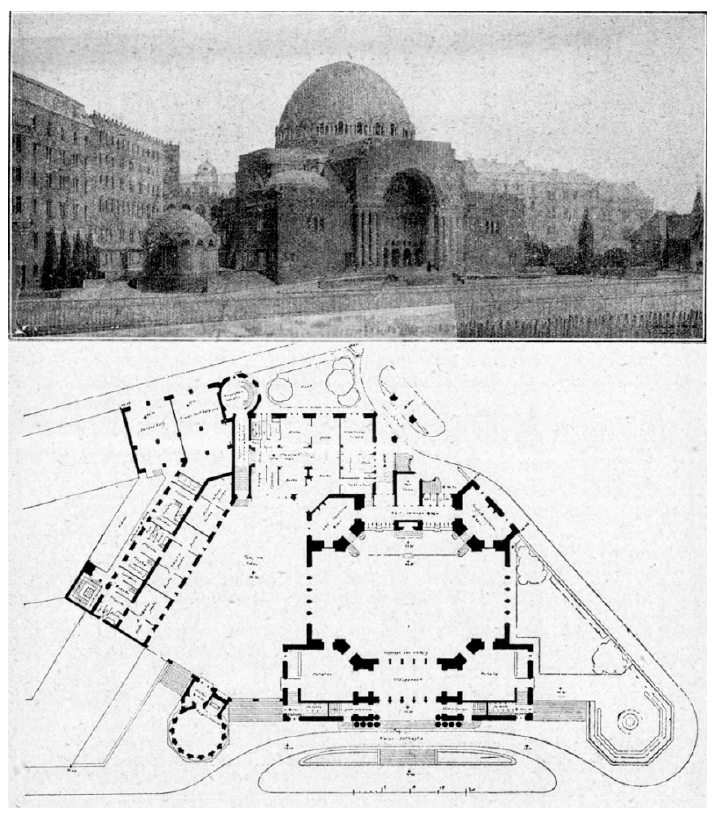
Figure 8. Perspective view and floor-plan of the Buda synagogue from the 3rd competition entry of Imre Gondos in 1914. Source: Épít ő Ipar – Épít ő M ű vészet , 22 March 1914, p. 120.